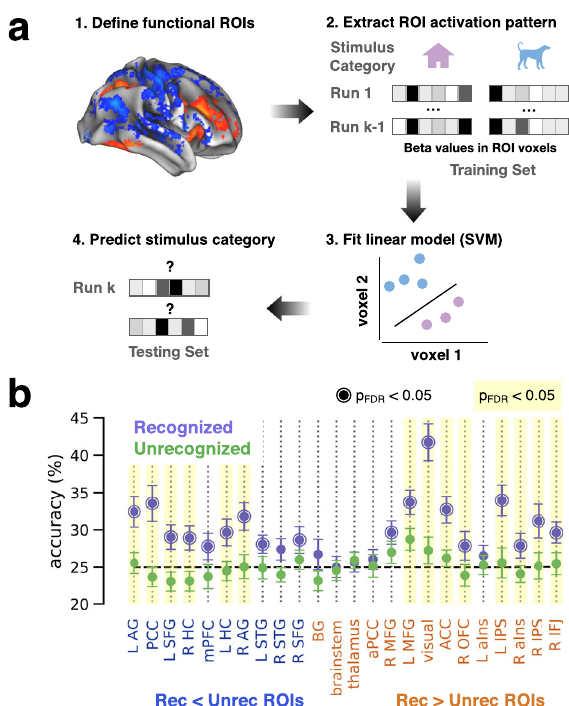
Fig. 4 Decoding object category from multi-voxel activity patterns within ROIs. a Schematic of the ROI-based decoding procedure. For each ROI, GLM-estimated activation values across voxels (seven voxels shown for simplicity) from a subset of the data (training data) were used to train a classi fi er to distinguish between stimulus categories. Held out data (testing data) were then used to test whether the classi fi ers could accurately decode stimulus category from new activation patterns. Separate classi fi ers were created for subjectively recognized objects and unrecognized objects. b Classi fi er accuracy within ROIs (locations shown in Fig. 3a) that were de fi ned by greater activation (blue labels) or deactivation (orange labels) in response to recognized compared to unrecognized image trials. Rings around data points: signi fi cant difference from chance. Shaded columns: signi fi cant difference between recognized and unrecognized. p < 0.05, one- sided label permutation test, FDR-corrected across all ROIs. Error bars indicate standard error of the mean across subjects ( N =